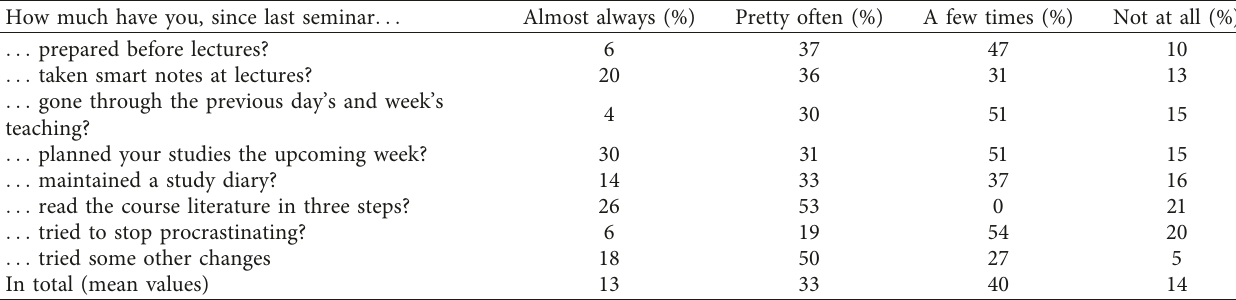
Table 3: Results from the postquestionnaire on how often the students tried the new skill. How much have you, since last seminar .